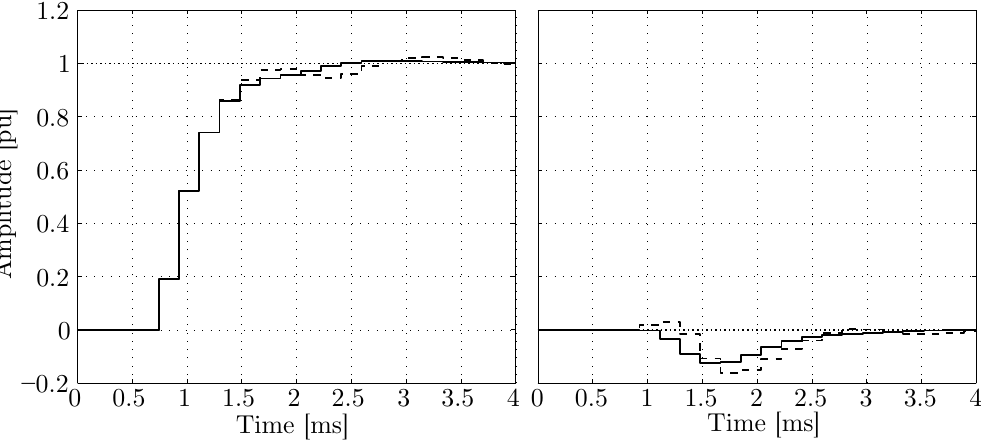
Figure 11. Simulation. Step response of ( left ) F d p ( z ) and ( right ) F dq p ( z ) (solid) using predictions and (dashed) without